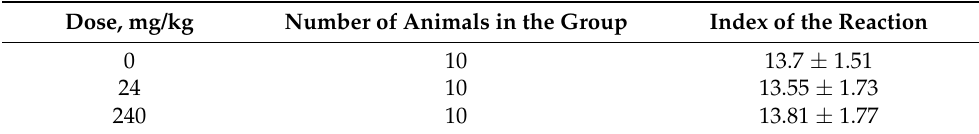
Table 3. The influence of substance on the inflammation reaction to Concanavalin A. Dose,